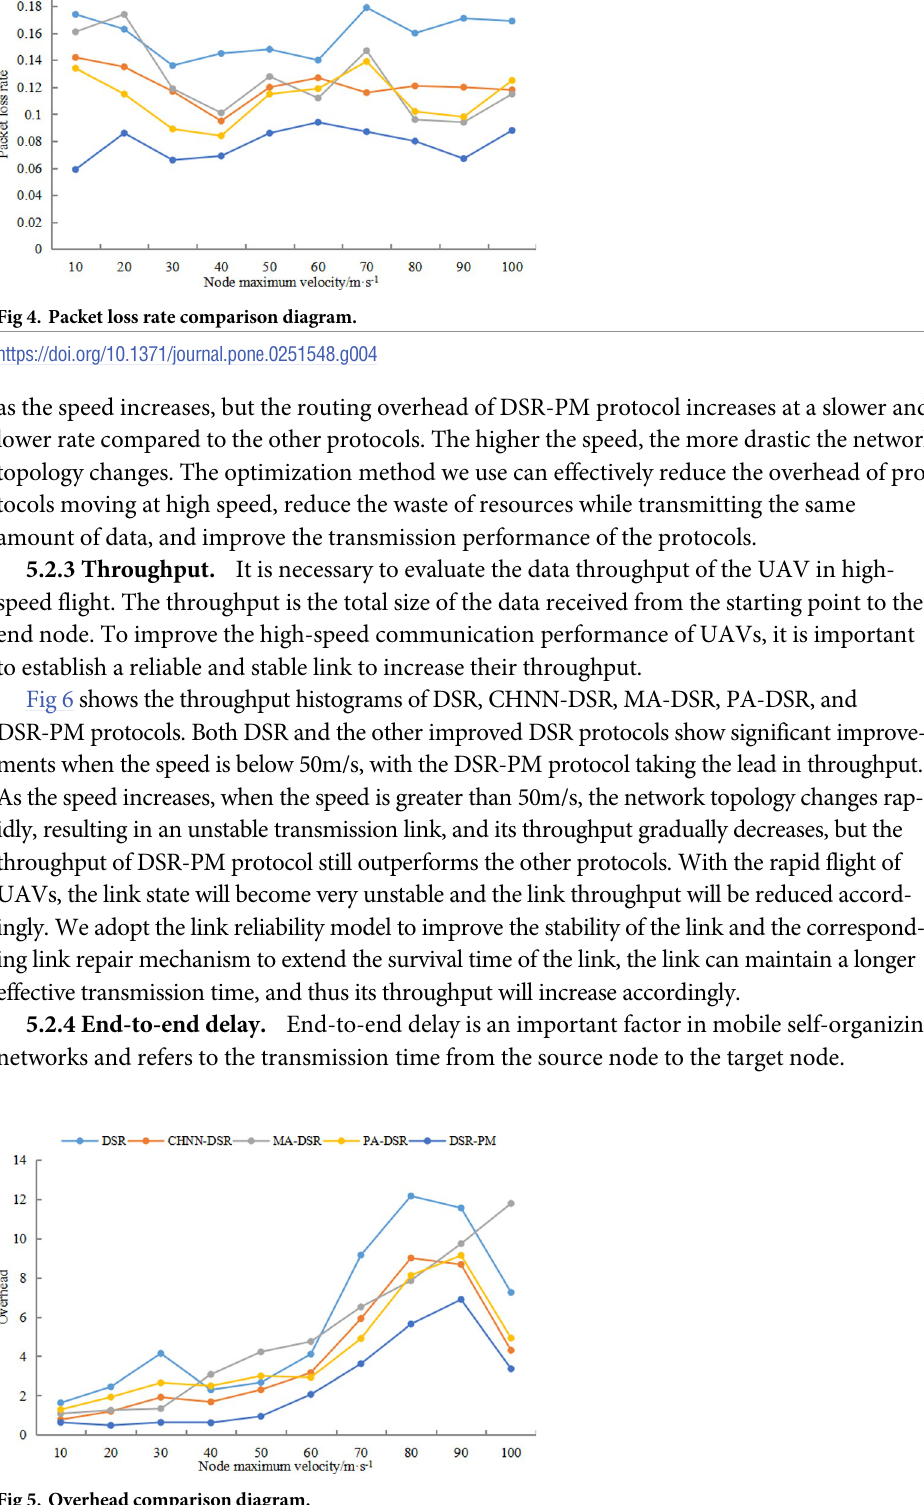
Fig 5. Overhead comparison